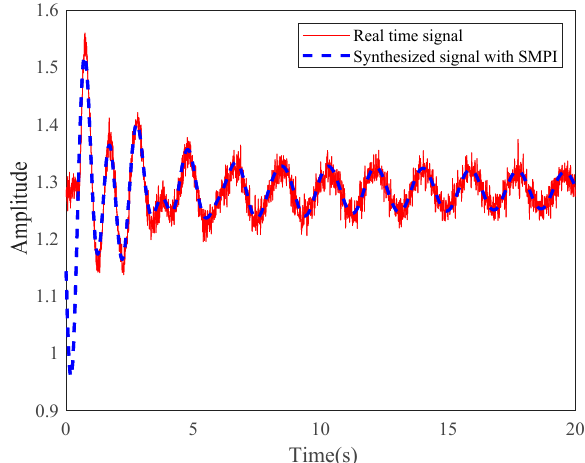
Figure 19. Comparison of Y and c EMD ( t ) of the real-time signal.